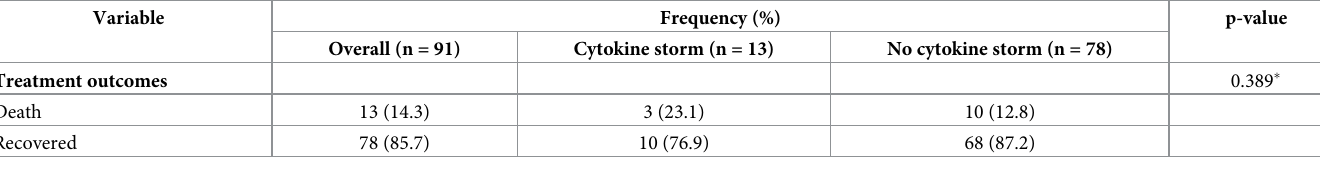
Table 3. Correlation between cytokine storm experienced and treatment outcomes.